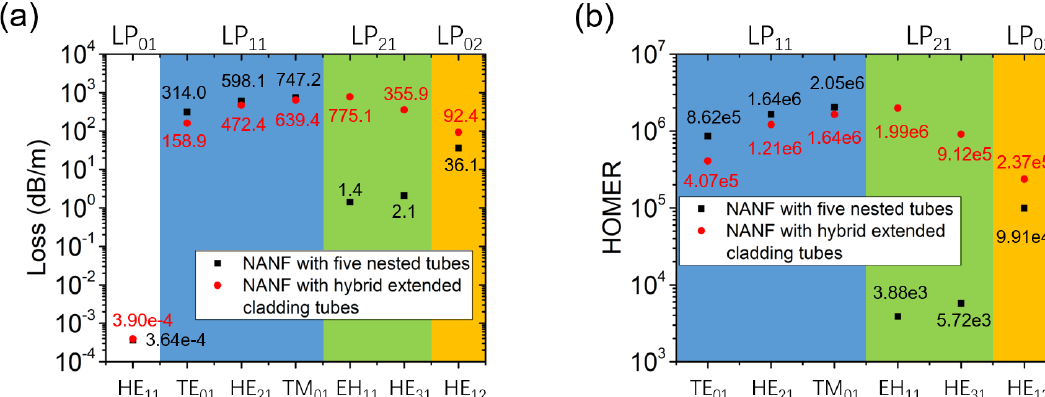
Figure 9. A comparison of ( a ) the loss and ( b ) the HOMER between an NANF with hybrid extended cladding tubes of parameters D tube1 = 0.80 D core , D tube2A = 0.69 D core , D tube2B = 0.51 D core and l = 9.4 × 1040 nm (red points) and an NANF with five nested tubes of parameters D tube1 = 1.21 D core and D tube2 = 0.69 D core (black squares).